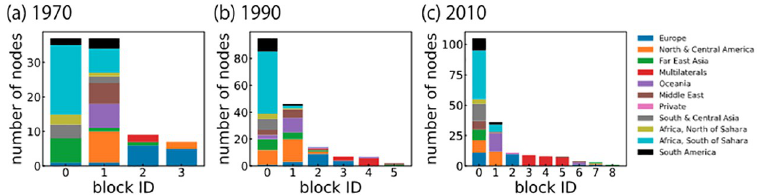
Fig 6. Regions or types in FAN stable blocks in (a) 1970, (b) 1990, and (c) 2010. The number of actors of each region or type in each block. Governments are labeled by the regions of their countries, while IGOs and NGOs are labeled as multilateral and private, respectively. The labels are available from OECD data. The stable blocks are in descending order of size.